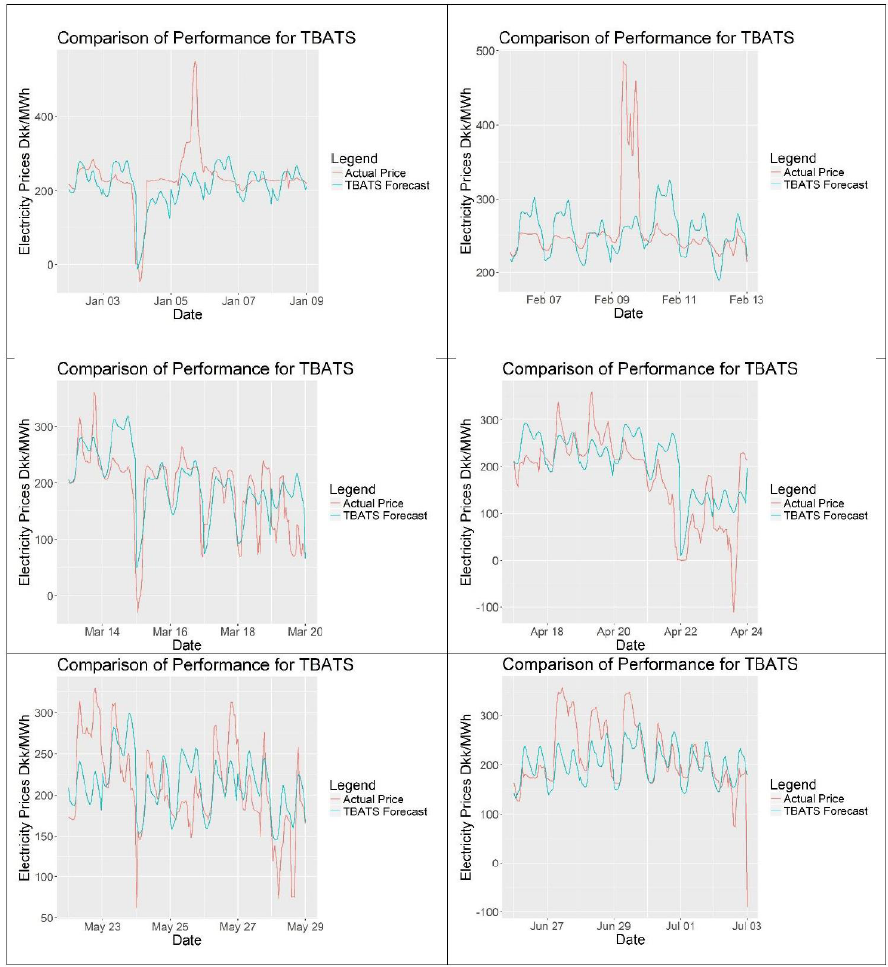
Figure 17. Six different weekly periods for TBATS.